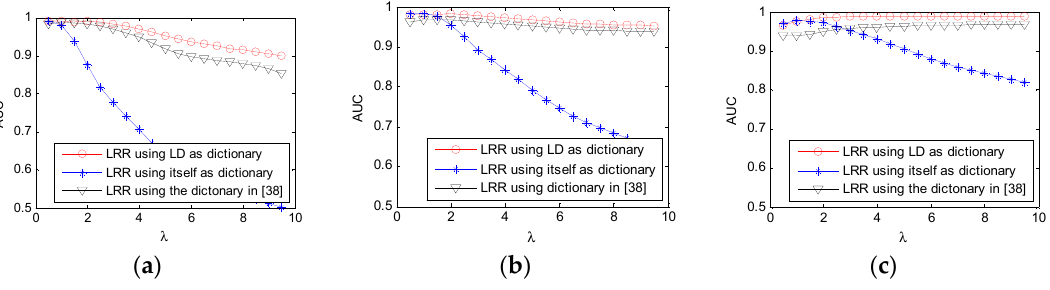
Figure 7. AUC with different tradeoff parameter λ under simple background using different dictionaries: ( a ) F1; ( b ) F2; and ( c ) V1.